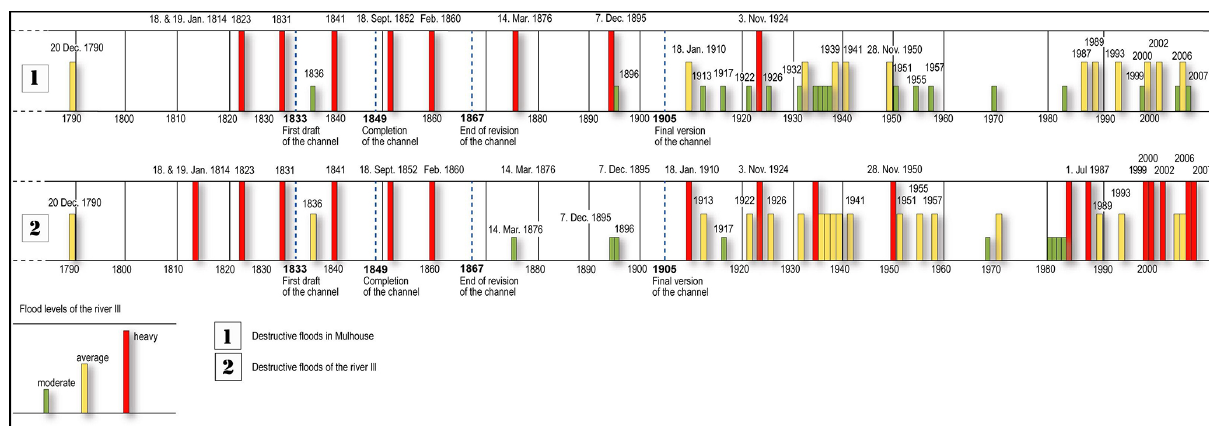
Figure 16. Changes in flood intensity due to technical alterations in